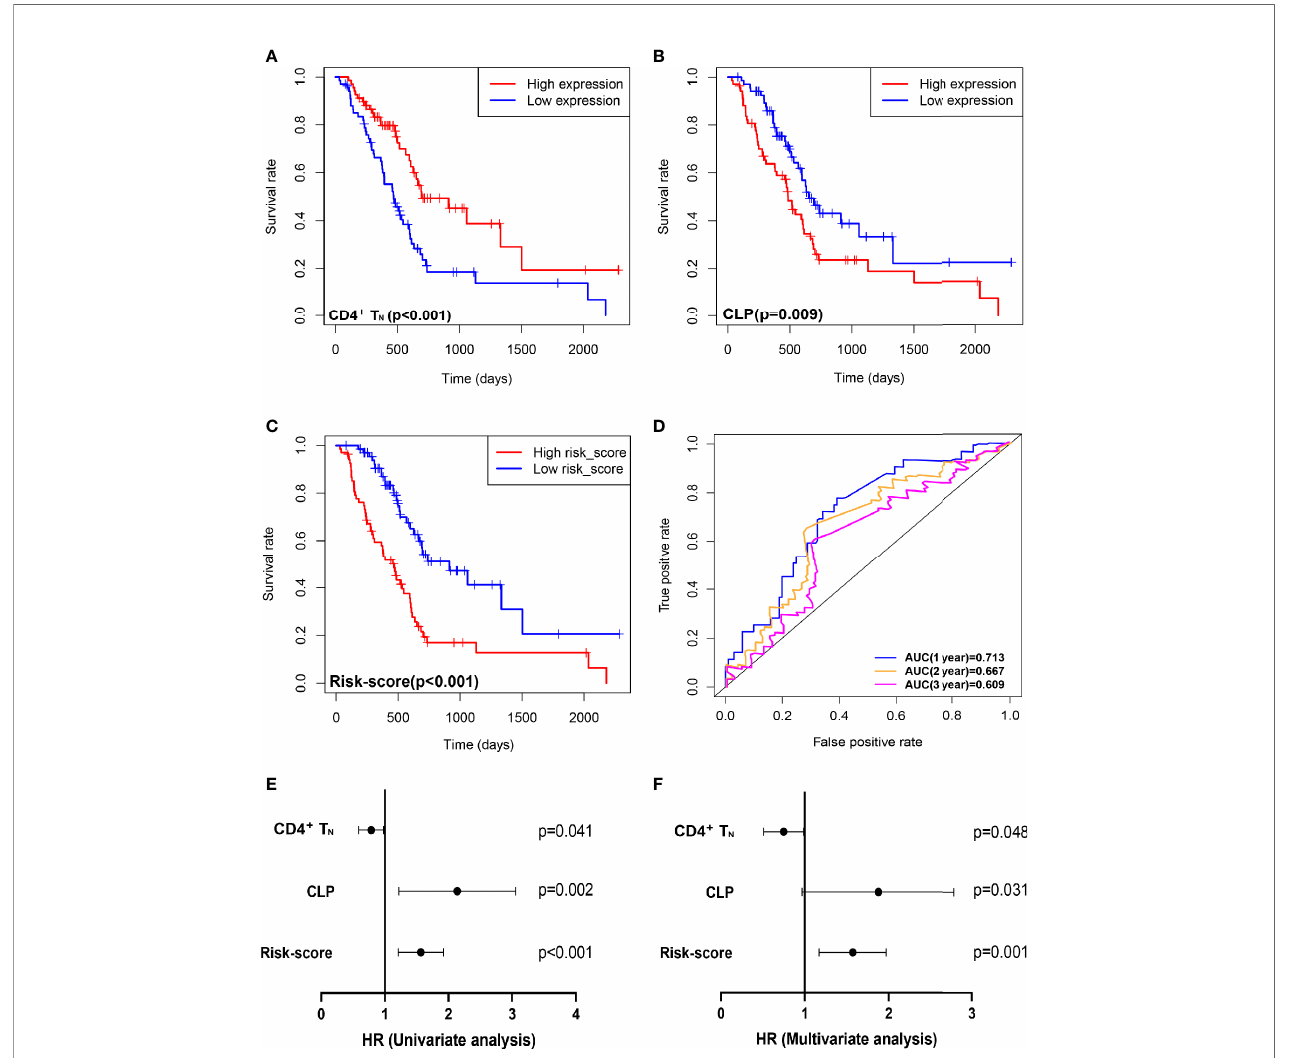
FIGURE 1 | Combining intratumoral in fi ltrating CD4 + T N and CLP to construct a Cox model can improve the sensitivity of predicting OS in TCGA PDAC discovery cohort. (A – C) OS in CD4 + T N , CLP, and risk-score high vs . low in fi ltrating cell/risk-score patients depicted by KM plots in TCGA PDAC discovery, respectively. (D) ROC curves to depict the accuracy of risk score in identifying poor OS in TCGA PDAC discovery cohort for 1, 2, and 3 years, respectively. (E, F) Forest plot showing the HR of CD4 + T N , CLP, and risk score in the univariate and multivariate Cox analyses, respectively. OS, overall survival; KM, Kaplan – Meier; HR, hazard ratios; CLP, common lymphoid progenitor; TCGA, The Cancer Genome Atlas; PDAC, pancreatic ductal adenocarcinoma; ROC, receiver operating